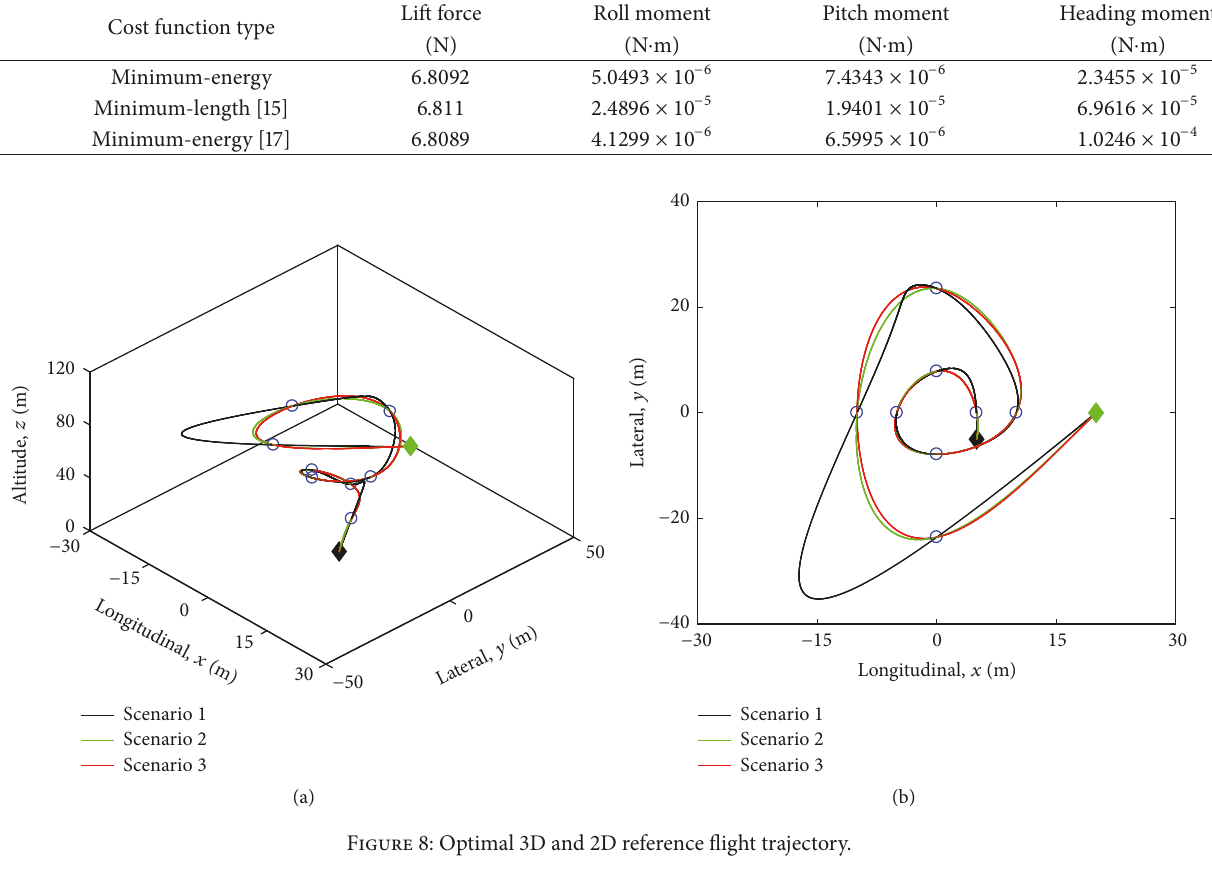
Figure 8: Optimal 3D and 2D reference flight trajectory.